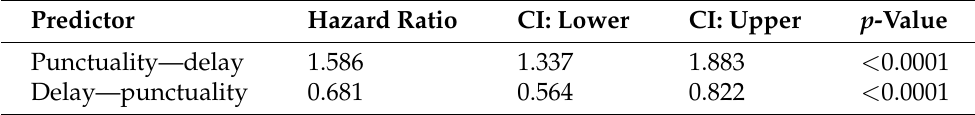
Table 7. Estimated hazard ratios between segments [ 330,end ) and [ 0,330 )